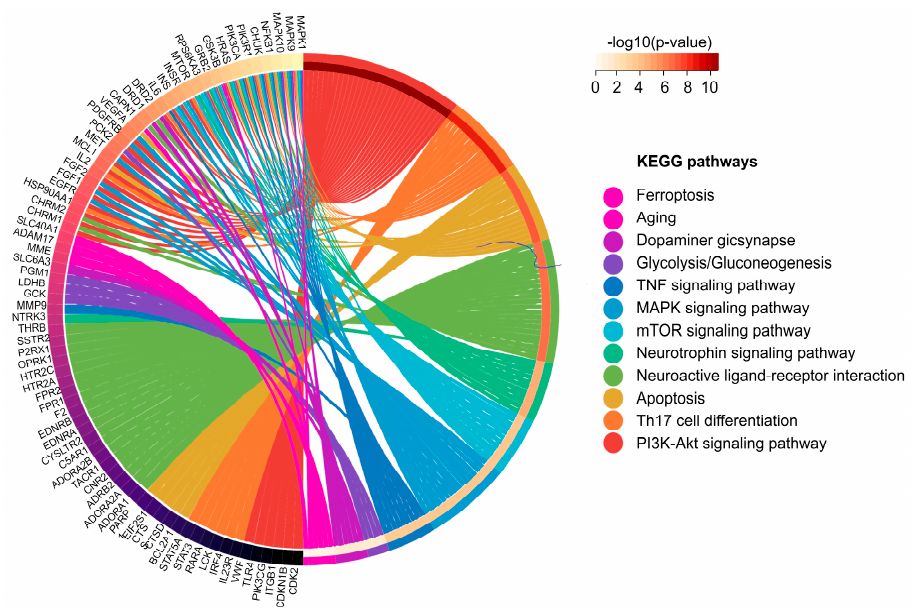
Figure 2. Circle diagram of the significant KEGG pathways.